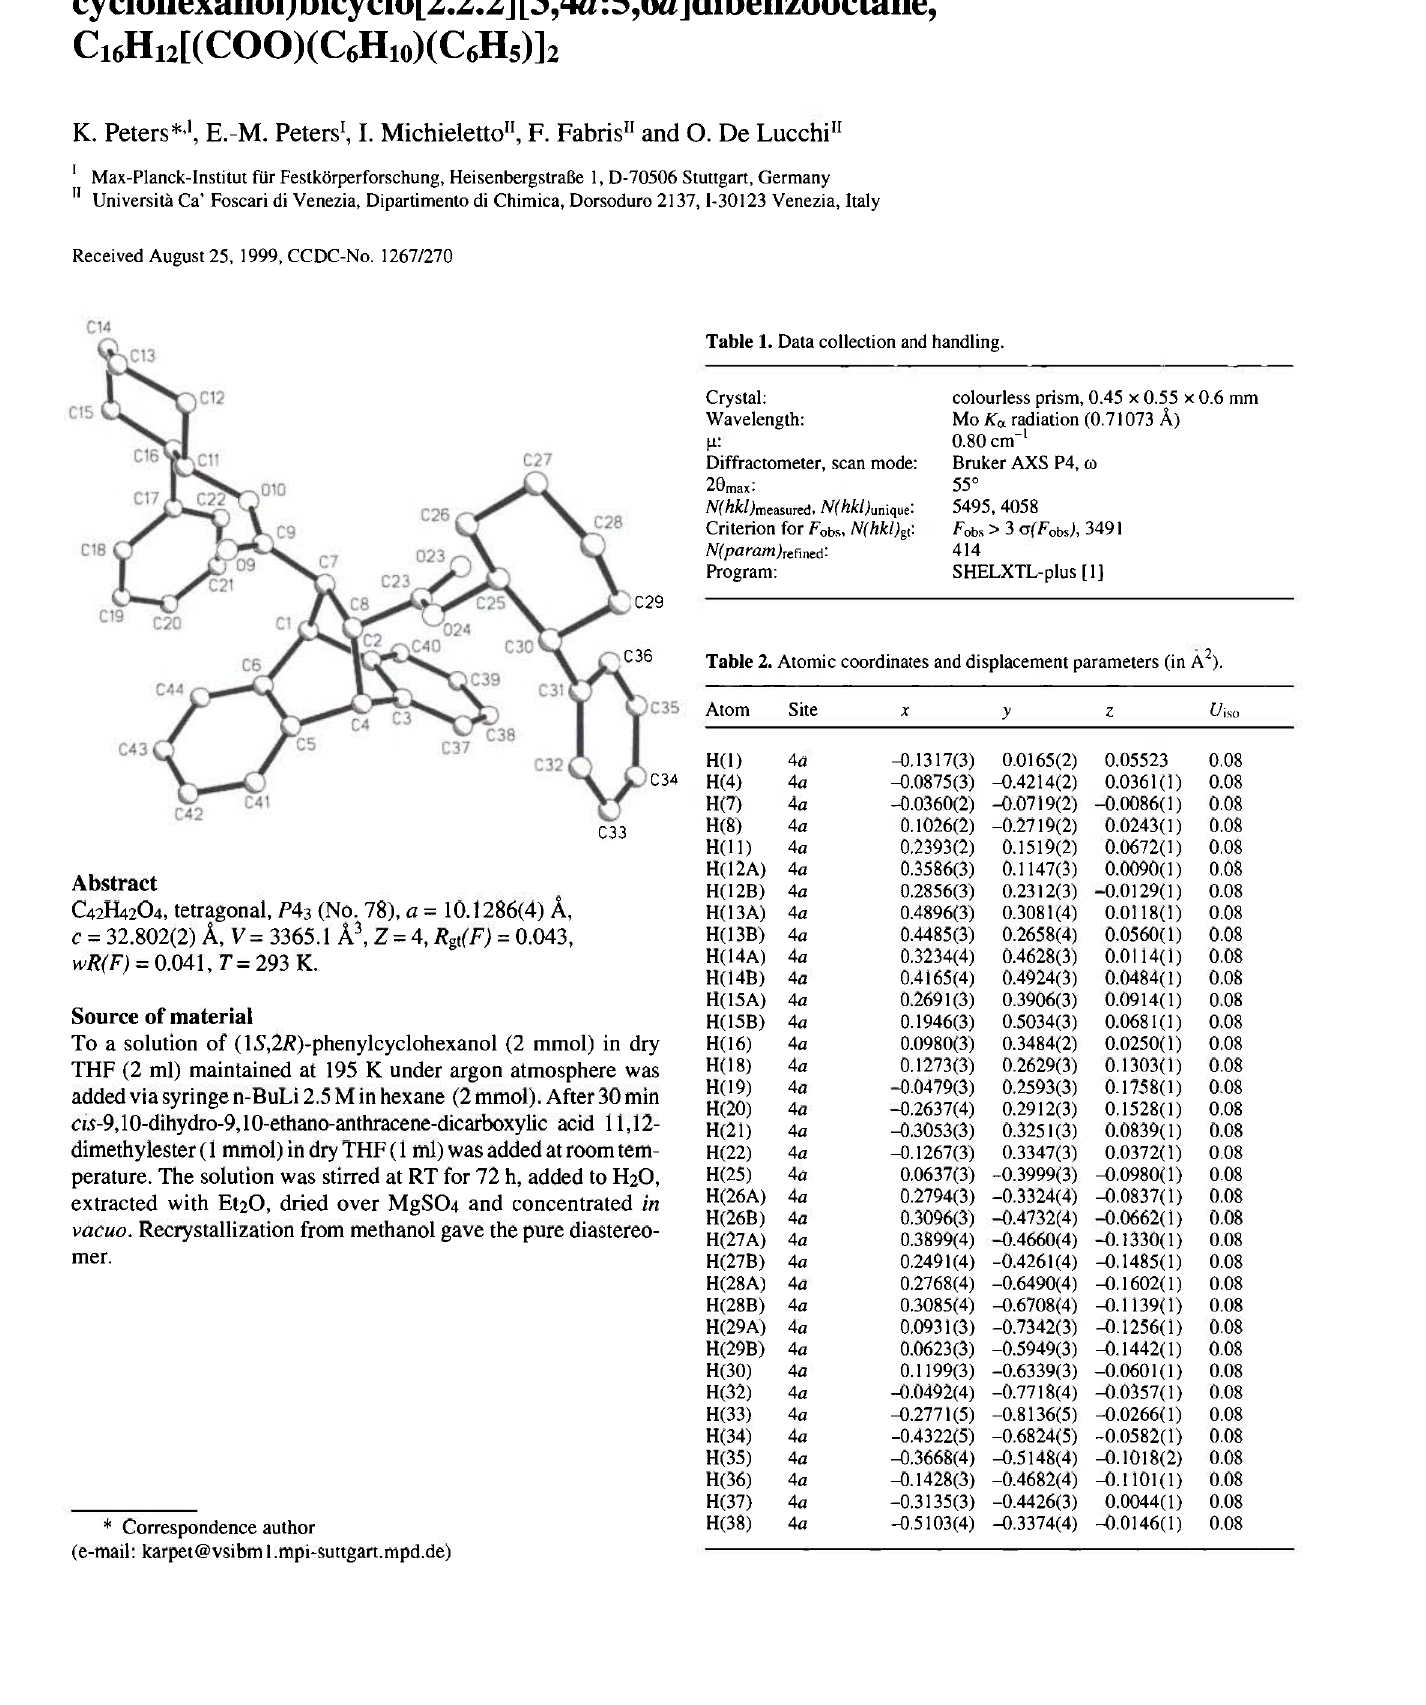
Table 2. Atomic coordinates and displacement parameters (in A 2